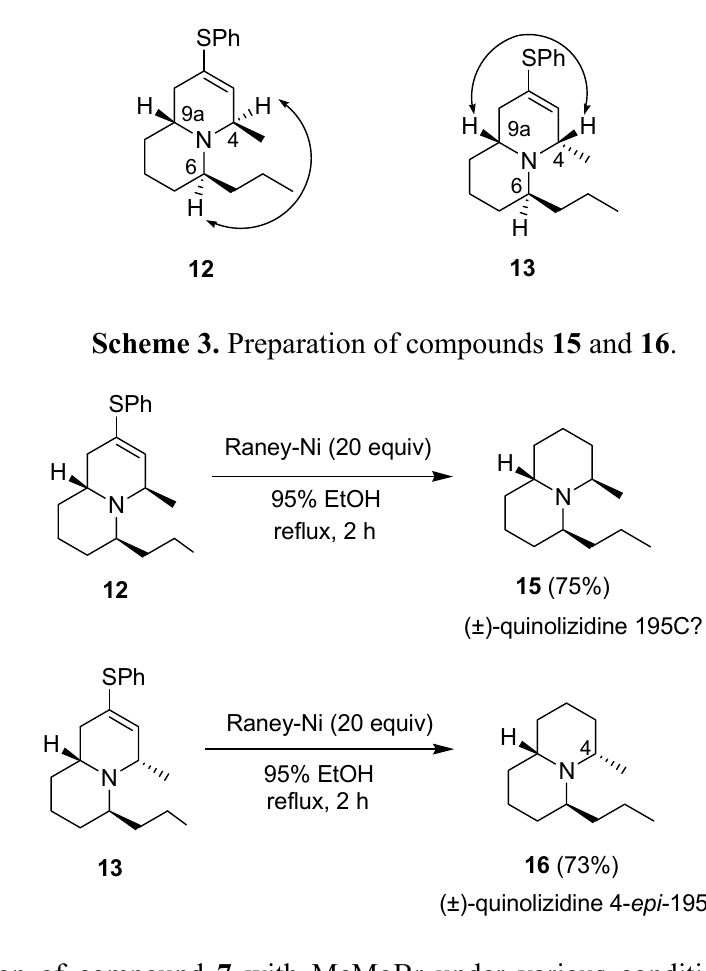
Figure 2. NOESY correlations of compounds 12 and 13 .